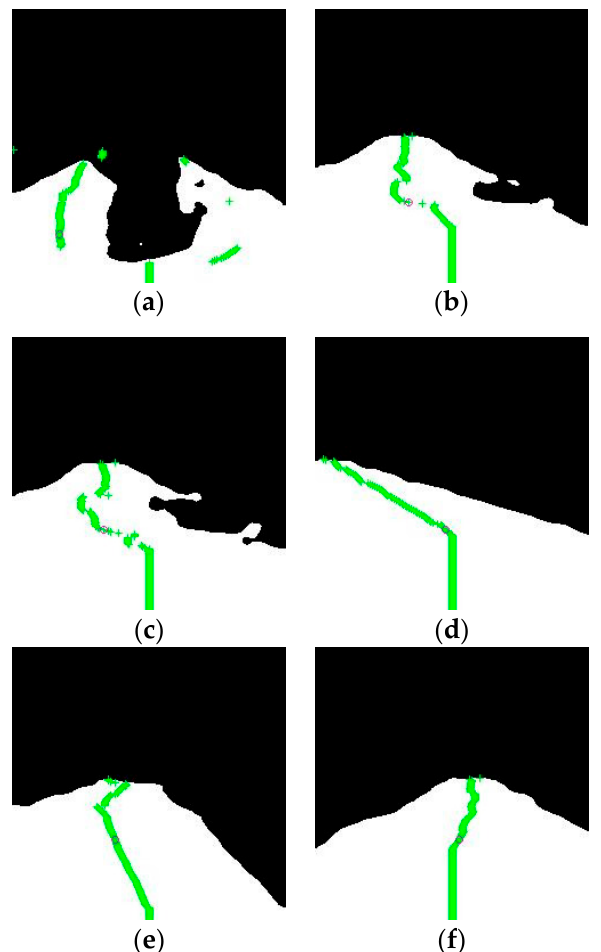
Figure 18. A binary image in which the white zone is the floor and black ones are the walls or obstacles: